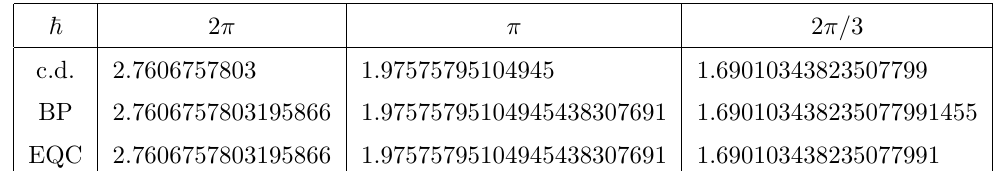
Table 1 . Real part of the (cid:12)rst resonance for local F 0 with log (cid:24) F of ~ . Here, c.d. denotes the complex dilatation method, while BP denotes the Borel-Pad(cid:19)e